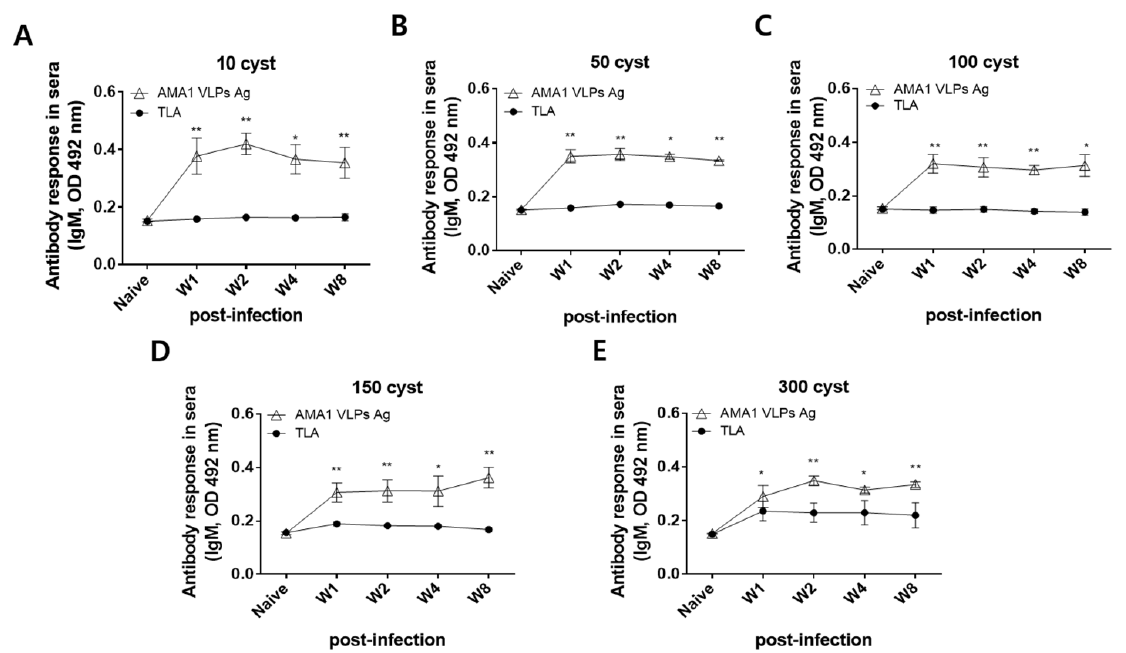
Figure 4. Reactivity of T. gondii ME49 infection-induced IgM antibody to AMA1 VLPs antigen. A total of 10 ( A ), 50 ( B ), 100 ( C ), 150 ( D ), or 300 ( E ) T. gondii ME49 cysts were inoculated into mice and infection sera were collected at 1, 2, 4, and 8 wpi. IgM responses to both TLA and AMA1 VLPs were assessed via ELISA. Data are presented as mean ± SD and are representative of the three individual experiments performed in triplicate (* p < 0.05, ** p < 0.01 vs. TLA).